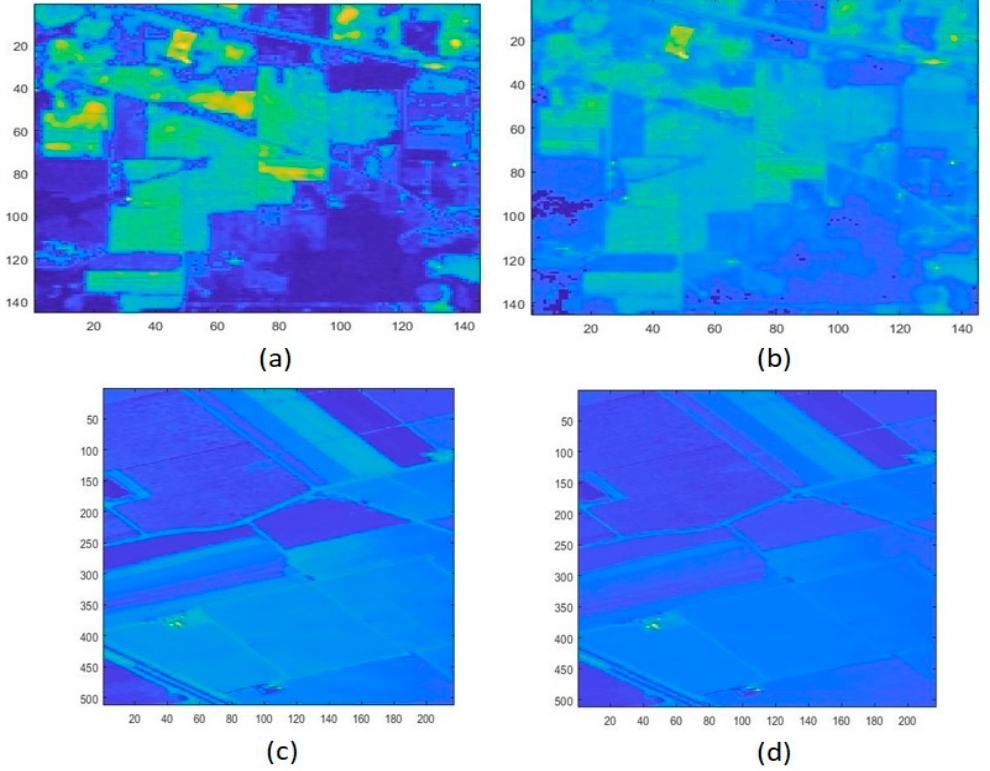
Figure 6. Different bands of Indian Pines data. ( a ) Red band with band number 29, ( b ) Green band with band number 15. For Salinas data ( c ) Red band with band number 29, ( d ) Green band with band number 15.